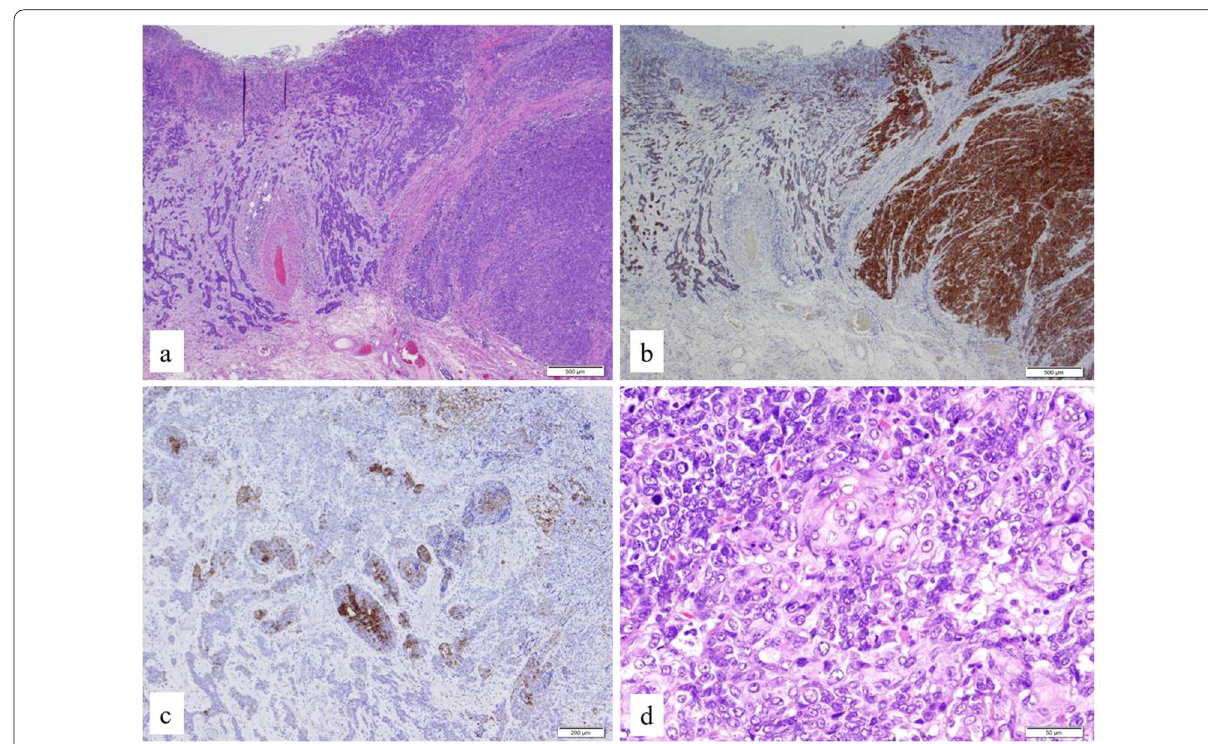
Fig. 2 Histopathological analysis using hematoxylin and eosin and immunohistochemistry. a Esophageal neuroendocrine carcinoma with features of adenoid cystic-like carcinoma and squamoid pattern (magnification, (magnification, 2). c Features of adenoid cystic-like carcinoma stained positive for cytokeratin 7 (magnification, × pattern (magnification,